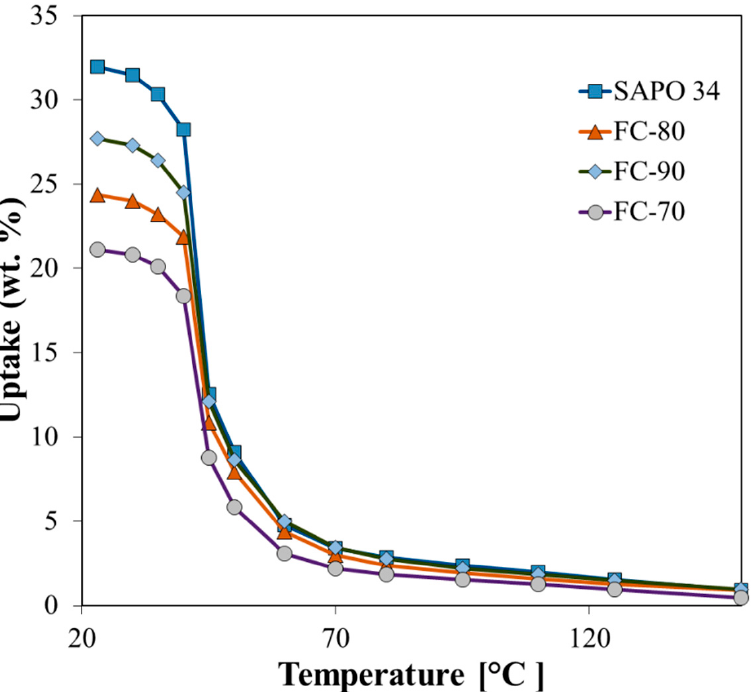
Figure 4. Water adsorption isobar (11 mbar) of the composite coatings filled with different zeolite filler content compared to pure SAPO-34 powder.